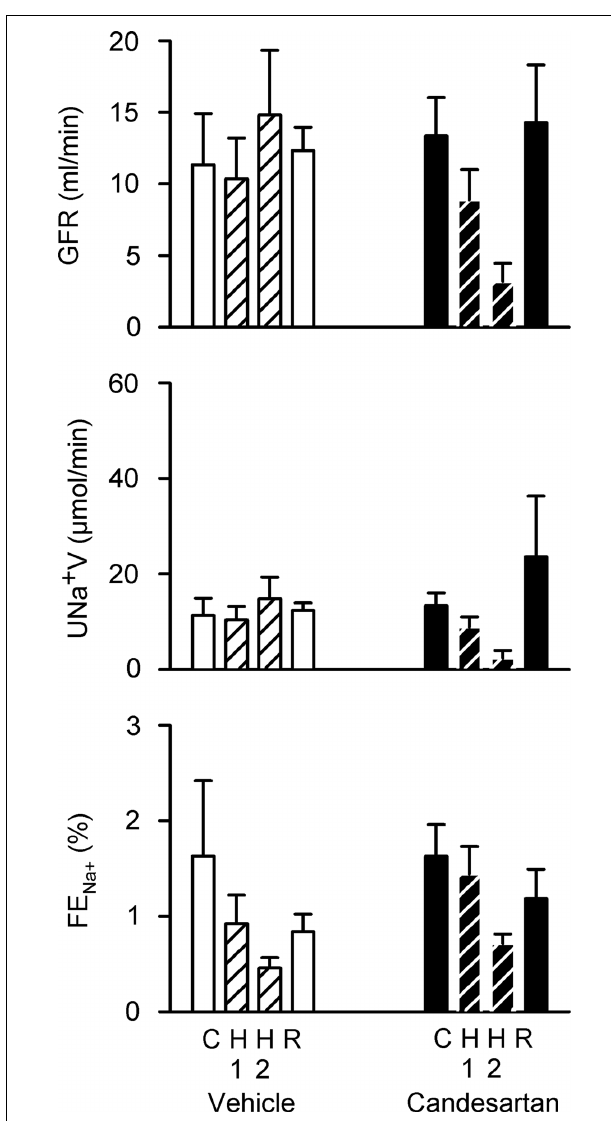
FIGURE 8 | Responses of renal excretory variables to progressive hemorrhage in conscious rabbits treated with candesartan or its vehicle. GFR, glomerular filtration rate; U Na + V, sodium excretion; FE Na + , fractional sodium excretion. H1 = 6ml/kg blood loss; H2 = 12ml/kg blood loss. P values for the outcomes of two-way repeated measures analysis of variance are shown in Table 2 .These failed to detect significant effects of candesartan or hemorrhage on GFR, U Na + V, and FE Na +